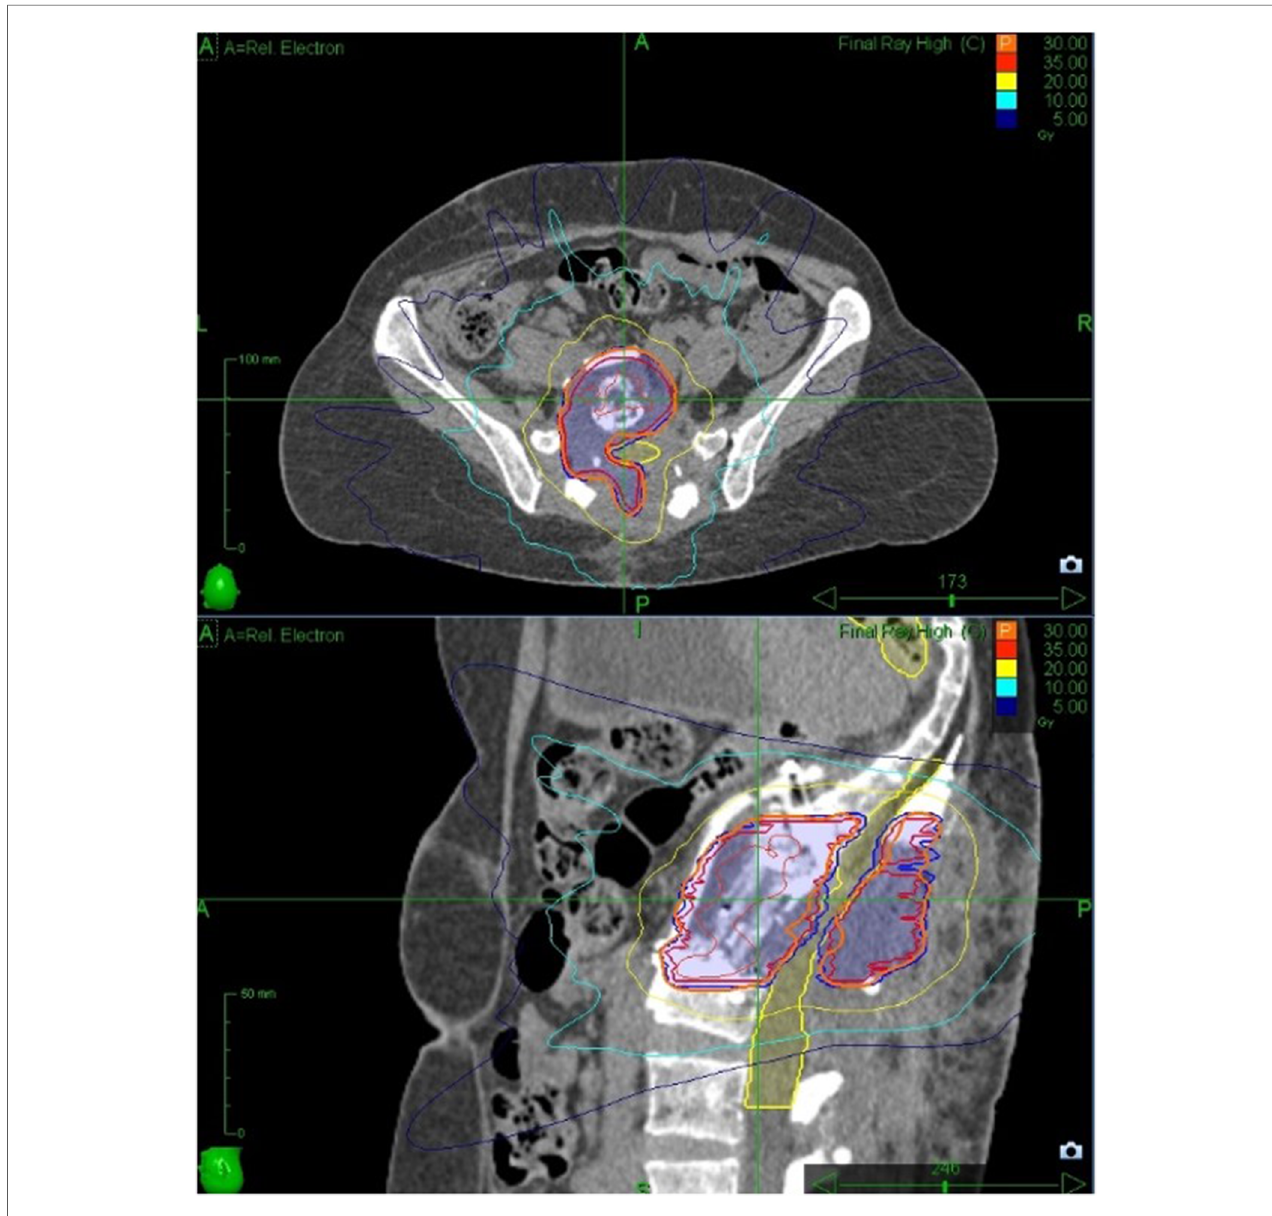
FIGURE 3 Dose distribution from planning